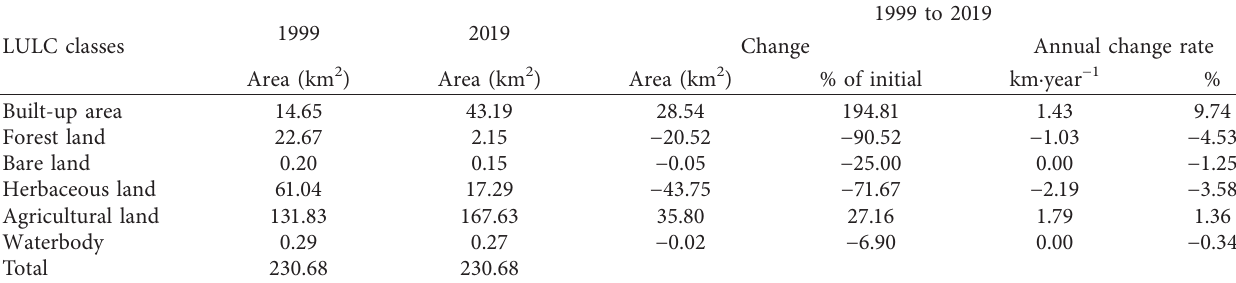
Table 9: LULC class annual change rate from 1999 to